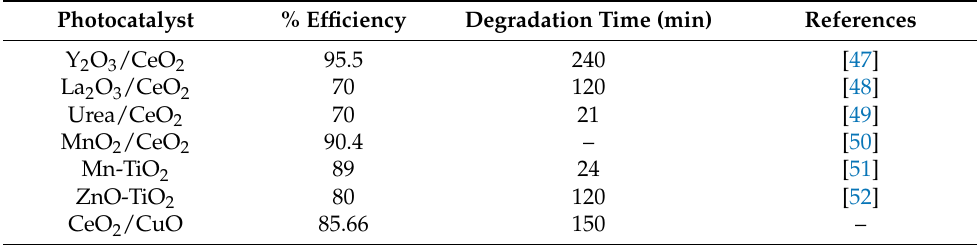
Table 2. Summary of some reported bimetallic oxides for photocatalytic dye